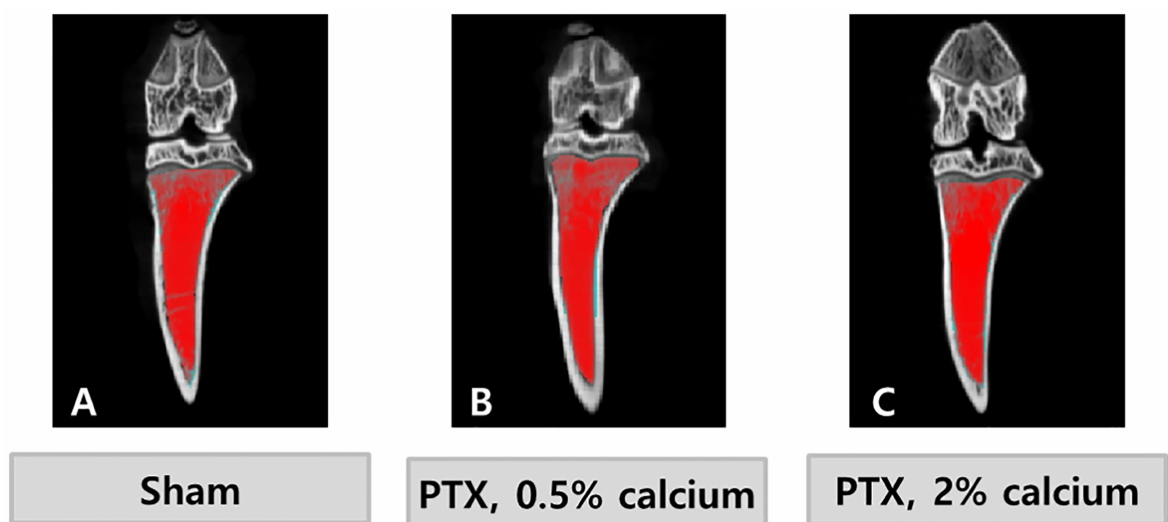
Fig 1. The region of interest (ROI) on microcomputerized tomography. A coronal view of the rat tibia. The ROI is indicatedas red color.